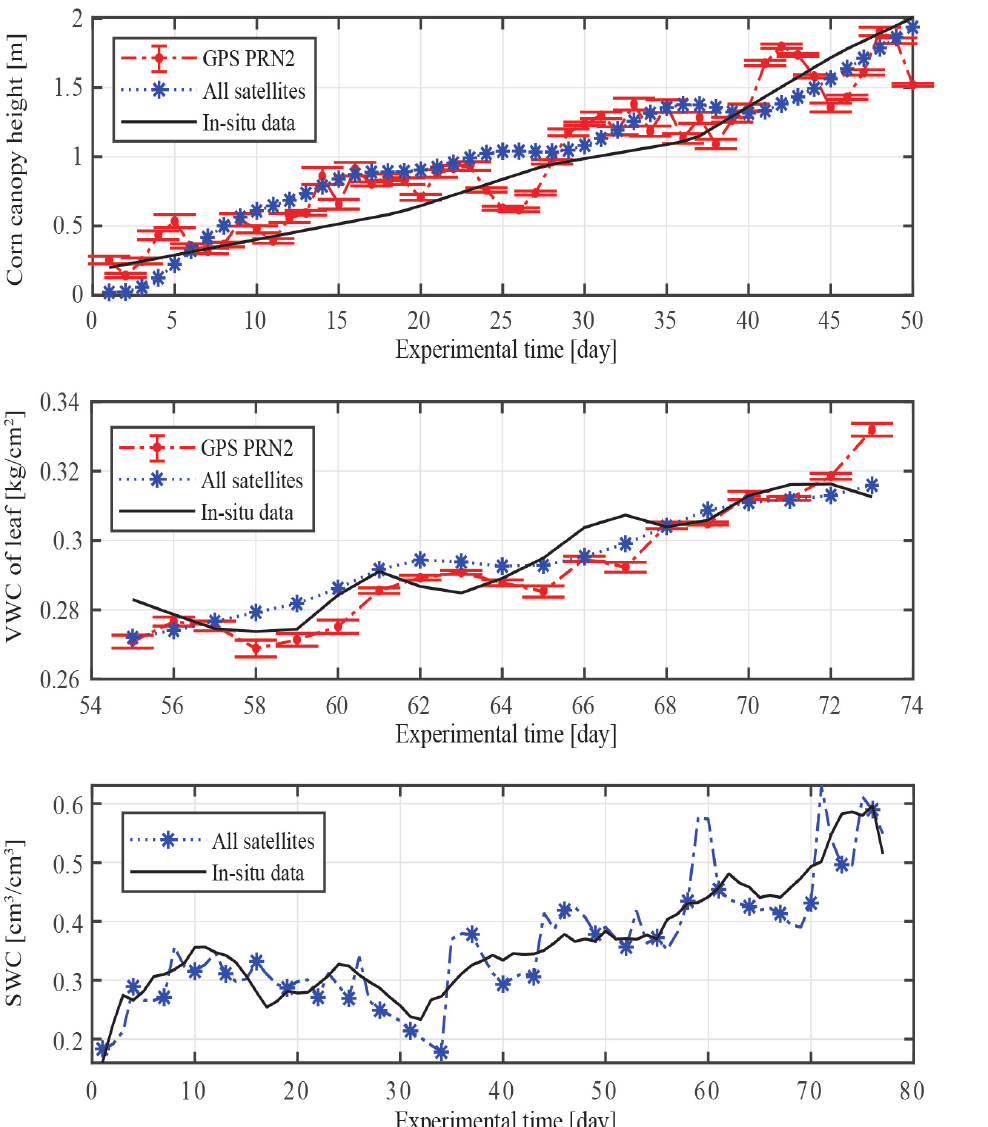
Figure 12. Comparison between the in situ data and retrieved